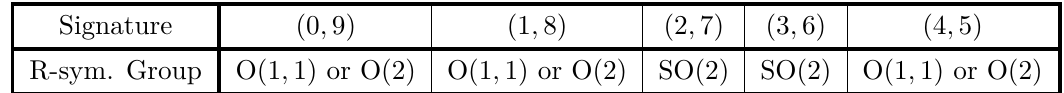
Table 11. N = 2 R-symmetry groups in nine dimensions, the R-symmetry group for ( s, t ) is the same as ( t, s )